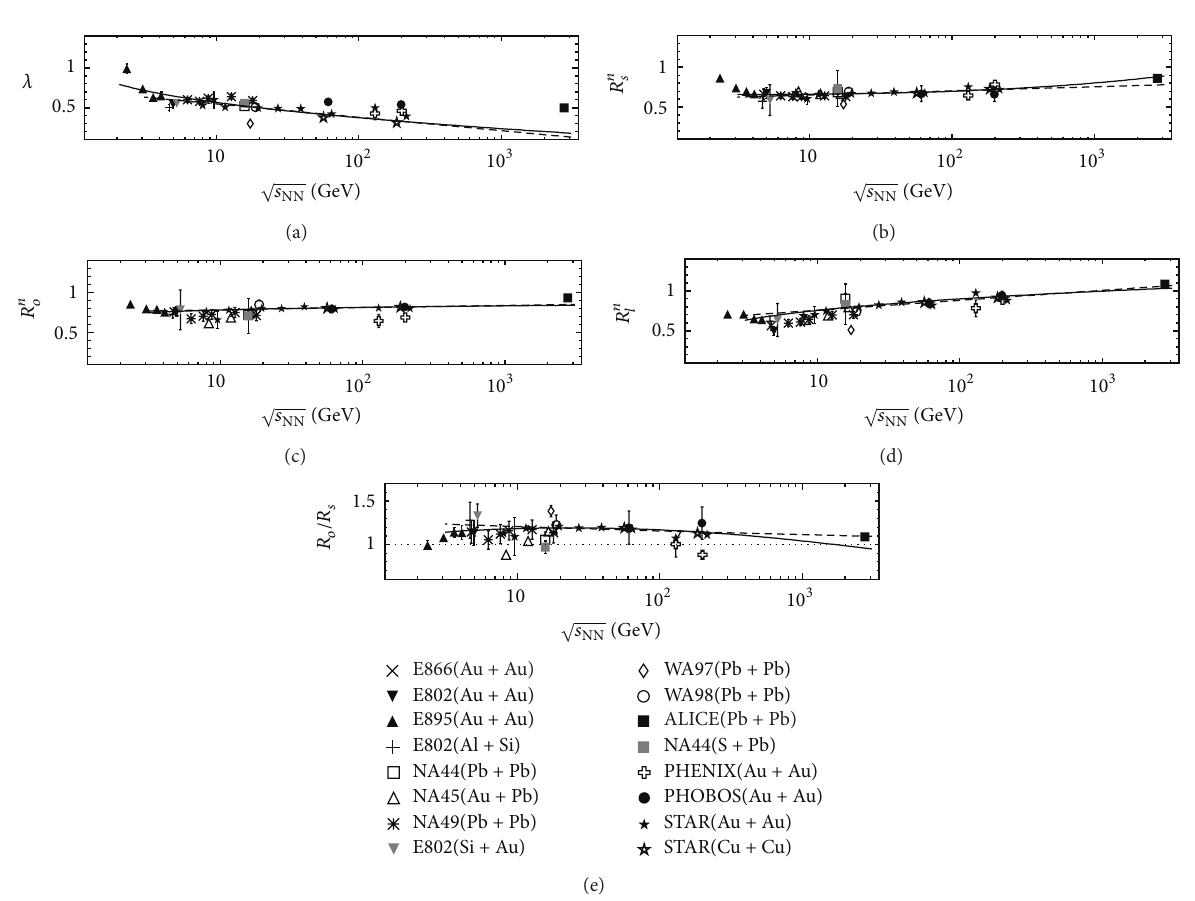
Figure 4: Energy dependence of 𝜆 parameter (a), scaled HBT radii (b–d), and ratio 𝑅 𝑜 /𝑅 𝑠 (e) in various nucleus-nucleus collisions at ⟨𝑘 ⊥ ⟩ ≃ 0.2 GeV/ 𝑐 [6]. Experimental results are shown for central collisions (for minimum bias event in the case of E802 for Al + Si), for pairs of 𝜋 − = 7.7 – 62.4 and 200 GeV for 𝜋 ± 𝜋 ± pairs, E802 for Al + Si, and mesons (in the cases of ALICE and STAR for both Cu + Cu and Au + Au at √𝑠 NN NA44 for S + Pb, for pairs of 𝜋 + mesons), and for standard Coulomb correction 𝑃 (1) 𝐶 (𝑞) (in the cases of ALICE, NA44, NA45, PHOBOS, and = 7.7, 11.5 – 62.4 and 200 GeV, for correction 𝑃 (3) STAR for both Cu + Cu and Au + Au at √𝑠 𝐶 ). Statistical errors are shown (for NA44, total NN uncertainties). The solid lines (a–d) correspond to the fits by function (7) and dashed lines to the fits by specific case of (7) at fixed 𝑎 3 = 1.0 . Smooth solid and dashed curves at (e) correspond to the ratio 𝑅 𝑜 /𝑅 𝑠 calculated from the fit results for 𝑅 𝑛 𝑠 and 𝑅 𝑛 𝑜 , and dotted line is the level /𝑅 = 1 𝑅 𝑜 𝑠